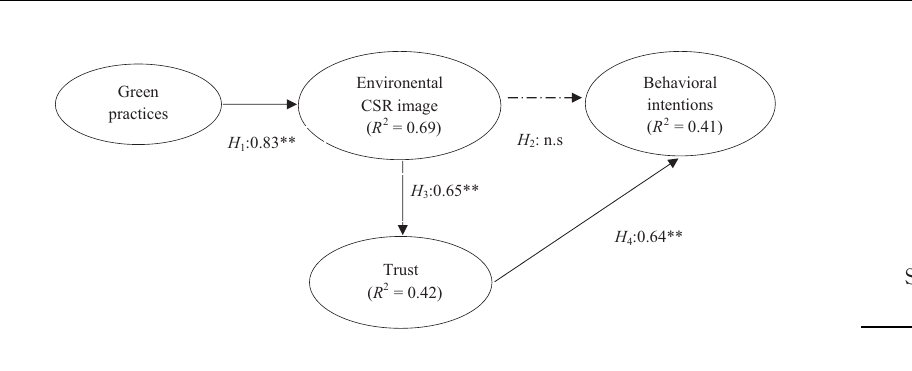
and Larcker ’ s criterion for discriminant